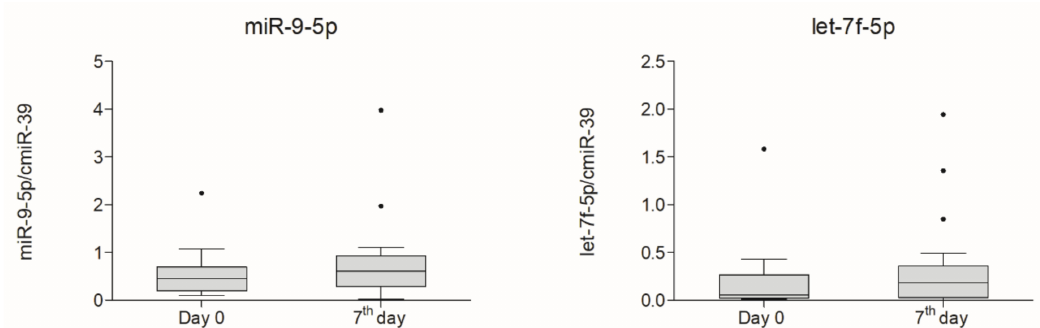
Figure 6. Boxplot of expression of analyzed miRNAs in cerebrospinal fluid measured on day zero and a week after intrathecal lineage-negative cells application ( n = 18). Statistical analysis was performed using Wilcoxon signed-rank test. Whiskers from 10th to 90th percentile. Horizontal line inside the box indicates the median. Level of significance-* p <